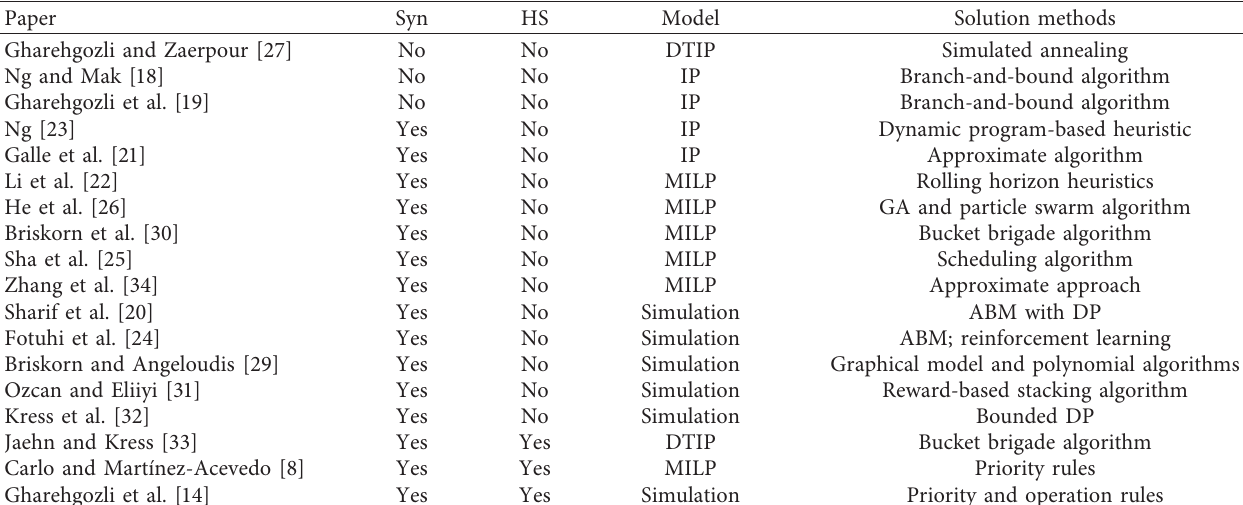
Table 1: Pioneering studies on scheduling yard cranes in container